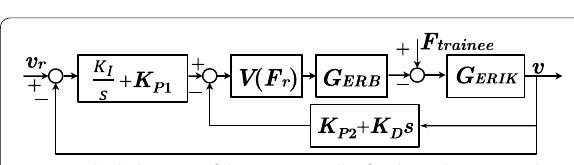
Fig. 13 Block diagram of the IPD controller for the isokinetic